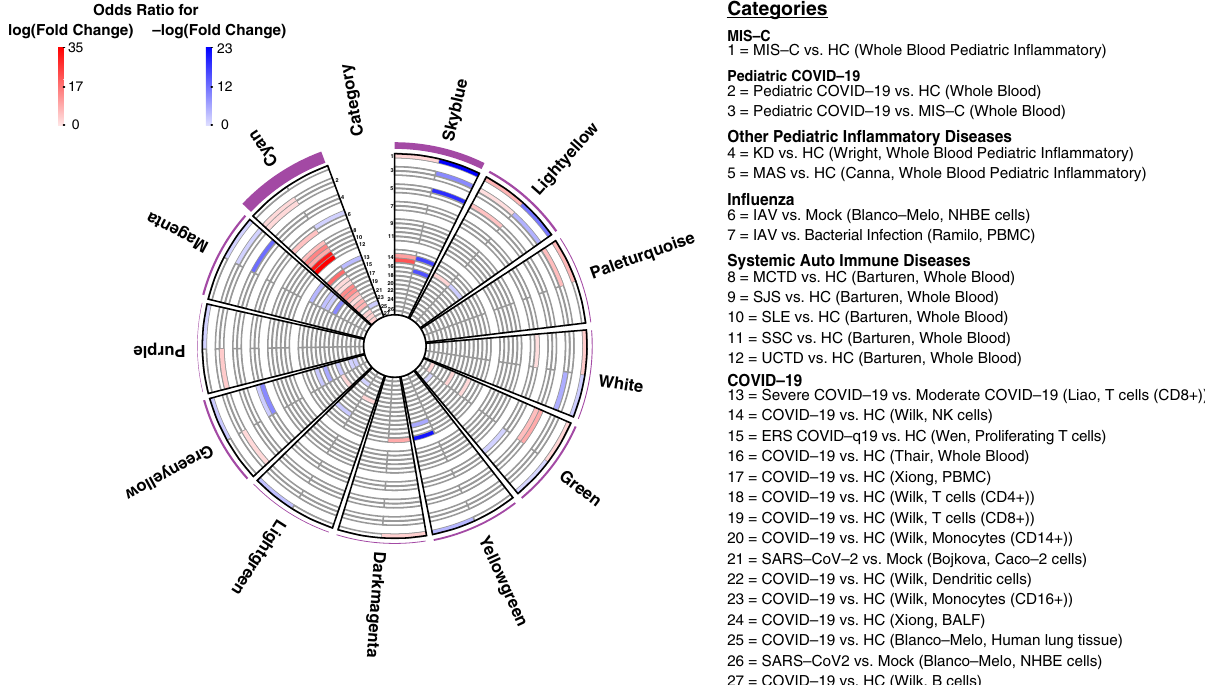
Fig. 4 Disease enrichments in MIS-C modules and cyan. Slices are modules and each circular row represents the corresponding disease signature de fi ned in the legend on the right. The purple outer rim of the plot represents the sum of the OR for all enrichments in that slice (performed using Fisher ’ s test). Each slice is divided into two components that show the OR for the enrichment of genes with ±log(fold change) in the corresponding disease signature (red and blue, respectively, as de fi ned in legend). Numbers in the category slice map the circular rows to disease signatures. ORs are shown for disease signature enrichment adjusted p -values < 0.05. Diseases were grouped in biologically meaningful clusters as de fi ned in the legend. Parenthesis in the legend refers to the source of the signature and the tissue or cell type assessed. References for disease signatures are de fi ned in the “ Methods ” section and all enrichments can be found in Supplementary Data